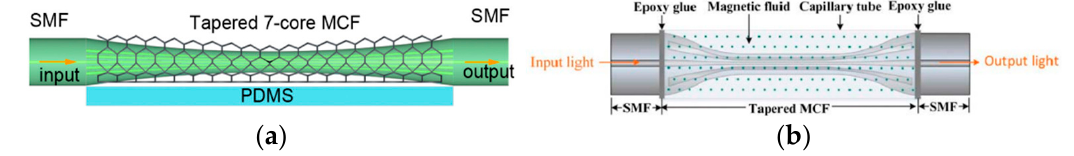
Figure 17. ( a ) Schematics of the tapered ‐ MMZI ‐ based refractive index sensor, in which the tapered part of the MCF is graphene ‐ coated [82]. PDMS: polydimethylsiloxane substrate. ( b ) Schematic of the tapered ‐ MMZI ‐ based magnetic ‐ field sensor, in which the sensing part is immersed in epoxy glue filled with the magnetic fluid [91].